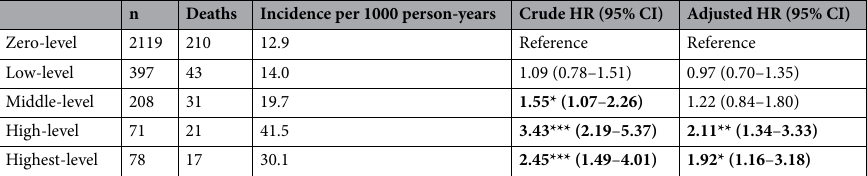
Table 4. Association between disengagement levels and mortality among older adults. Adjusted for sex, age at follow-up, self-rated health, frequency of going outdoors, chronic disease, instrumental activities of daily living disability, perceived financial status, and living arrangement at baseline. HR hazard ratio, CI confidence interval. Bold numbers are statistically significant (* p < 0.05, ** p < 0.01, *** p <